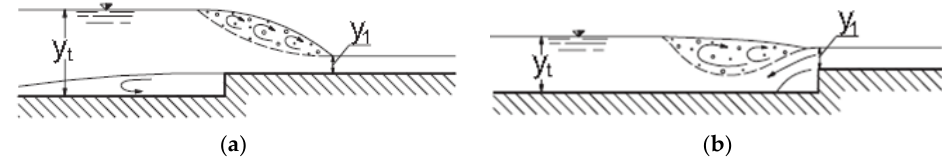
Figure 3. Flow conditions: ( a ) A-jump; and ( b ) B-jump (maximum plunging condition).